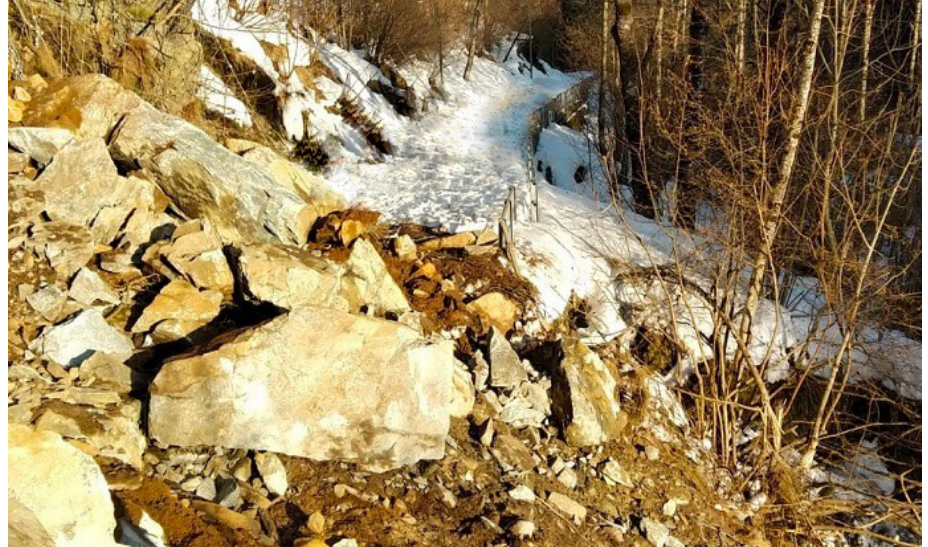
Figure 2. Rockfall event of 21 February 2021 (modified from: https://www.valsesianotizie.it/2021/0 2/21/leggi-notizia/argomenti/cronaca-9/articolo/rassa-frana-sulla-strada-per-piana-e-rassetta. html; accesed on 24 July